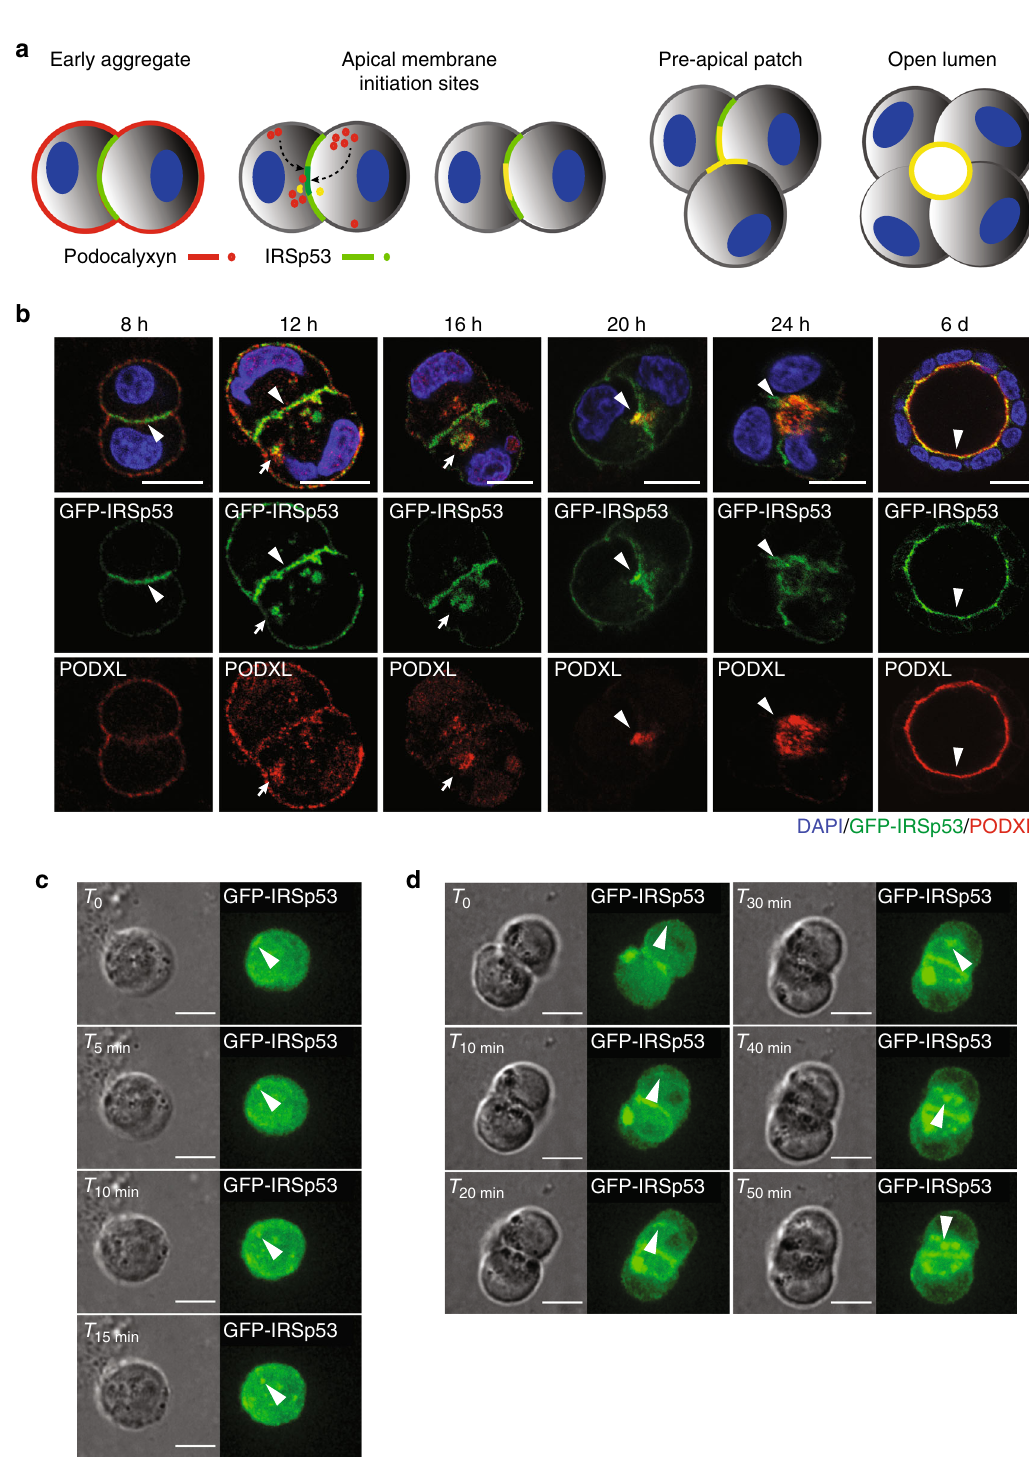
Fig. 3 IRSP53 precedes PODXL localization to the apical membrane. a Schematic representation of IRSp53 and PODXL traf fi cking during the early phases of lumenogenesis. b MDCK cells expressing GFP-IRSp53 were seeded as single cells on a Matrigel layer and left to grow to form three-dimensional (3D) cysts. The cysts were fi xed at the indicated time points, processed for epi fl uorescence to visualize GFP-IRSp53 (green) and stained with anti-PODXL (red) and DAPI (blue). Arrowheads, IRSp53 preceding PODXL relocalization at the AMIS at early time points; colocalization of IRSp53 and PODXL at the AMIS at later time points; and enrichment at the luminal side in the mature cyst. Arrows, IRSp53 and PODXL colocalization in vesicle-like structures. Scale bar, 18 µ m. c , d Still images of time lapse of GFP-IRSp53 during early phases of cystogenesis. MDCK expressing GFP-IRSp53 were seeded as single cells on a Matrigel. 6 h after seeding cells were subjected to time-lapse analysis using Confocal Spinning Disk microscope. Images (Bright Field and GFP channel respectively) were acquired every 5 min for 15 h (see also Supplementary Movies 2 and 3). White arrowheads indicate GFP-IRSp53 vesicular-like structures that emerge from the peripheral plasma membrane and move toward the inner ( c ) or the forming apical side at cleavage furrow immediately after the fi rst cell division ( d ). Scale bar, 10 µ